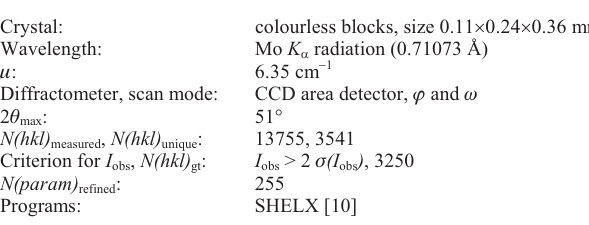
Table 1. Data collection and handling.